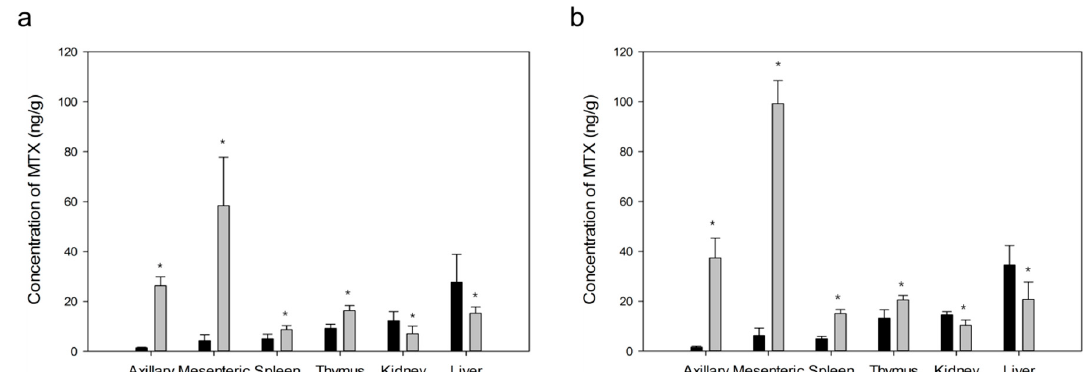
Figure 12. Concentrations of MTX in axillary and mesenteric lymph nodes, spleen, thymus, kidney and liver at 2.5 h after oral (a) or intravenous (b) administration of MTX-loaded PLGA NPs ( ■, 5 mg/kg as MTX ) and free MTX ( ■, 5 mg/kg ) to rats. Vertical bars represent mean ± SD ( n = 5). * p < 0.05